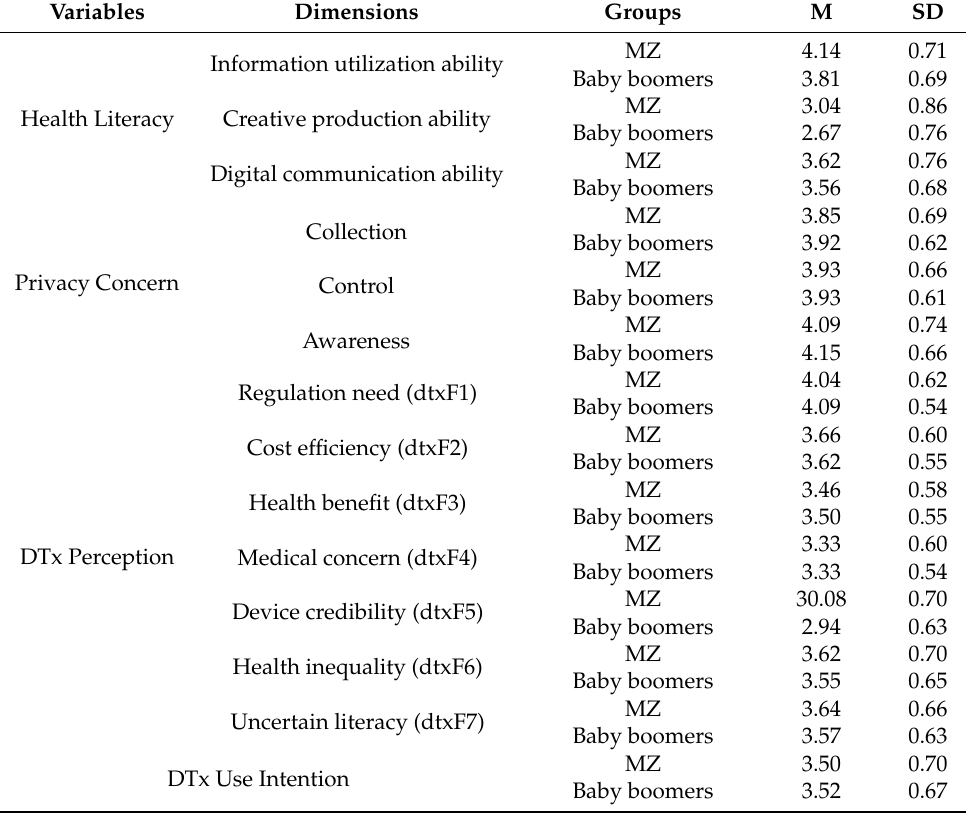
Table 4. The means and standard deviations of variables: MZ generation and baby boomers. Variables Dimensions